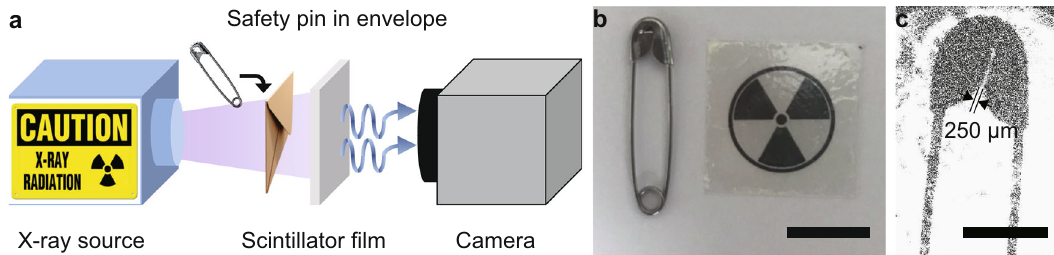
Fig. 6 X-ray imaging performance. a Scheme of X-ray imaging setup using 1:1 Li-(PEA) 2 PbBr 4 as scintillator. The safety pin is inside the envelope. b Bright- fi eld image of the safety pin and the Li-(PEA) fi lm on glass substrate with high transparency. Scale bar is 1 cm. c X-ray image (background corrected) 2 PbBr 4 of the safety pin. Black and white mode was applied for better contrast. Scale bar is 5